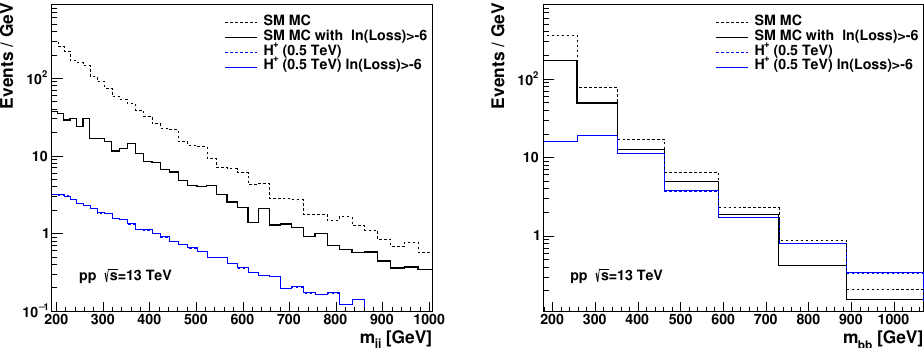
Figure 6. The distributions of the invariant masses in the outlier region with ln ( Loss ) > − 6. The masses were reconstructed for light-favor jets ( left ) and for b -jets ( right ) using SM Monte Carlo simulations. The blue line is the fit function (see the